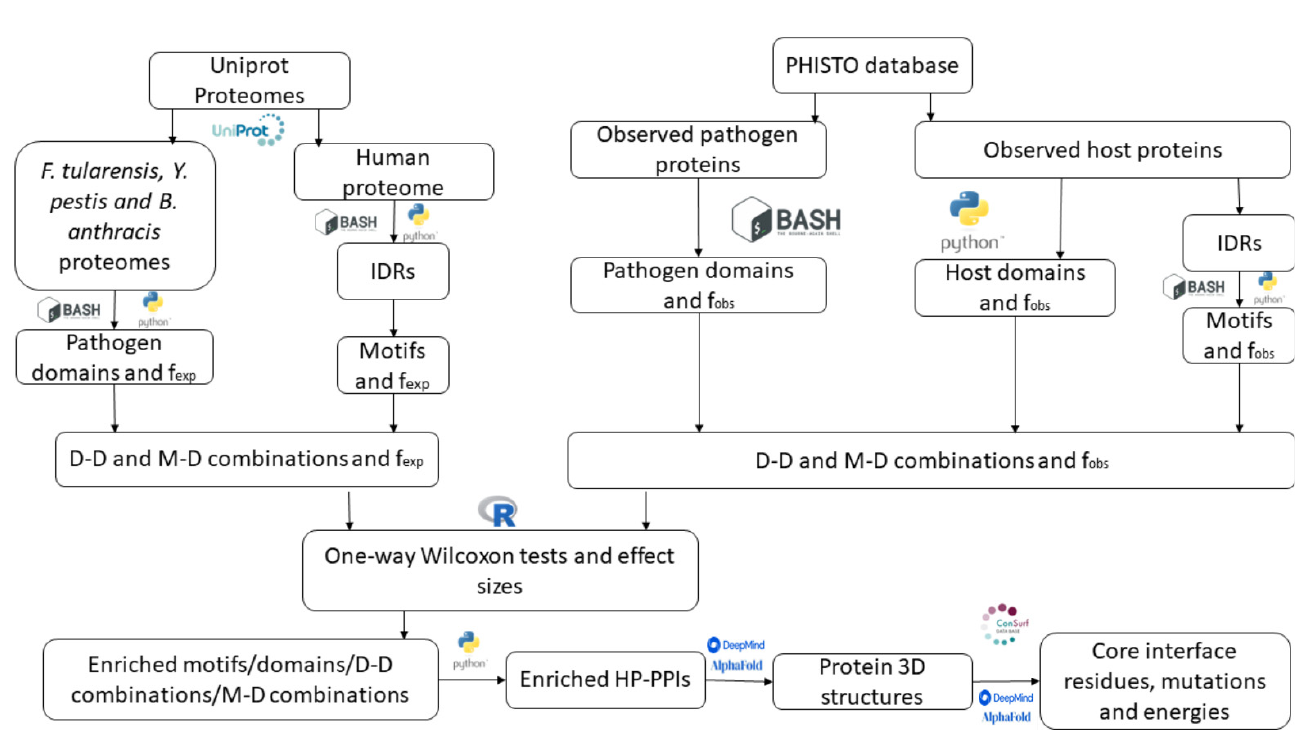
Figure 1. Workflow followed to retrieve HP-PPIs from the PHISTO database considering enriched motifs, domains, domain–domain and domain–motif associations, and to analyze the interface re- gions.